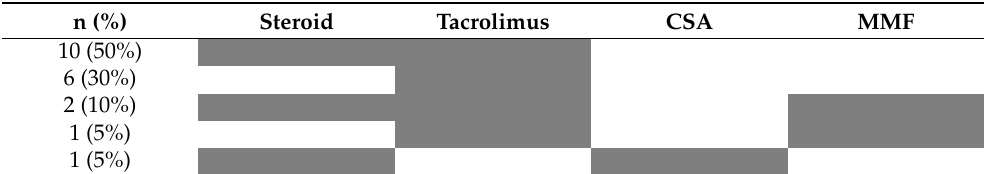
Table 1. Standard immunosuppression strategies in the first three weeks after paediatric liver transplantation in descending frequency. n (%) Steroid